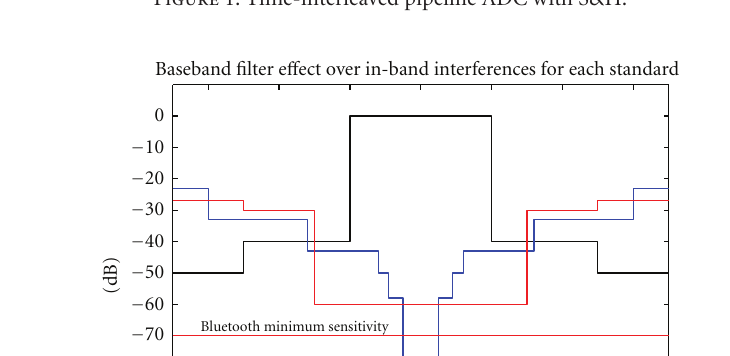
Figure 1: Time-interleaved pipeline ADC with S&H.